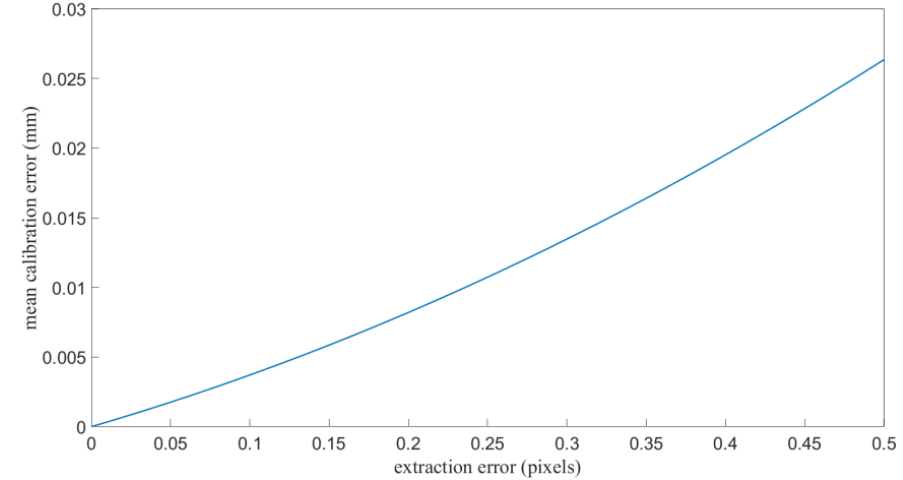
Figure 8. Mean calibration error in the plate area with different extraction error.